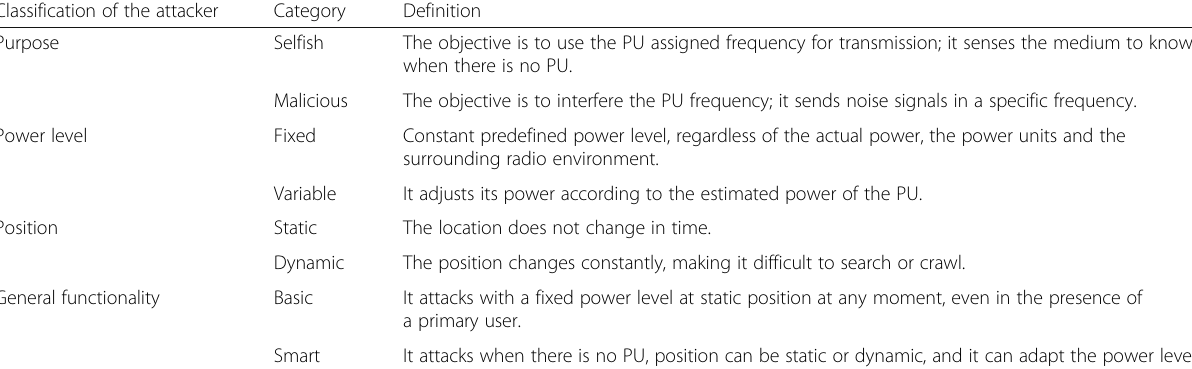
Table 1 PUE classification, adapted from [22, 29, 30] Classification of the